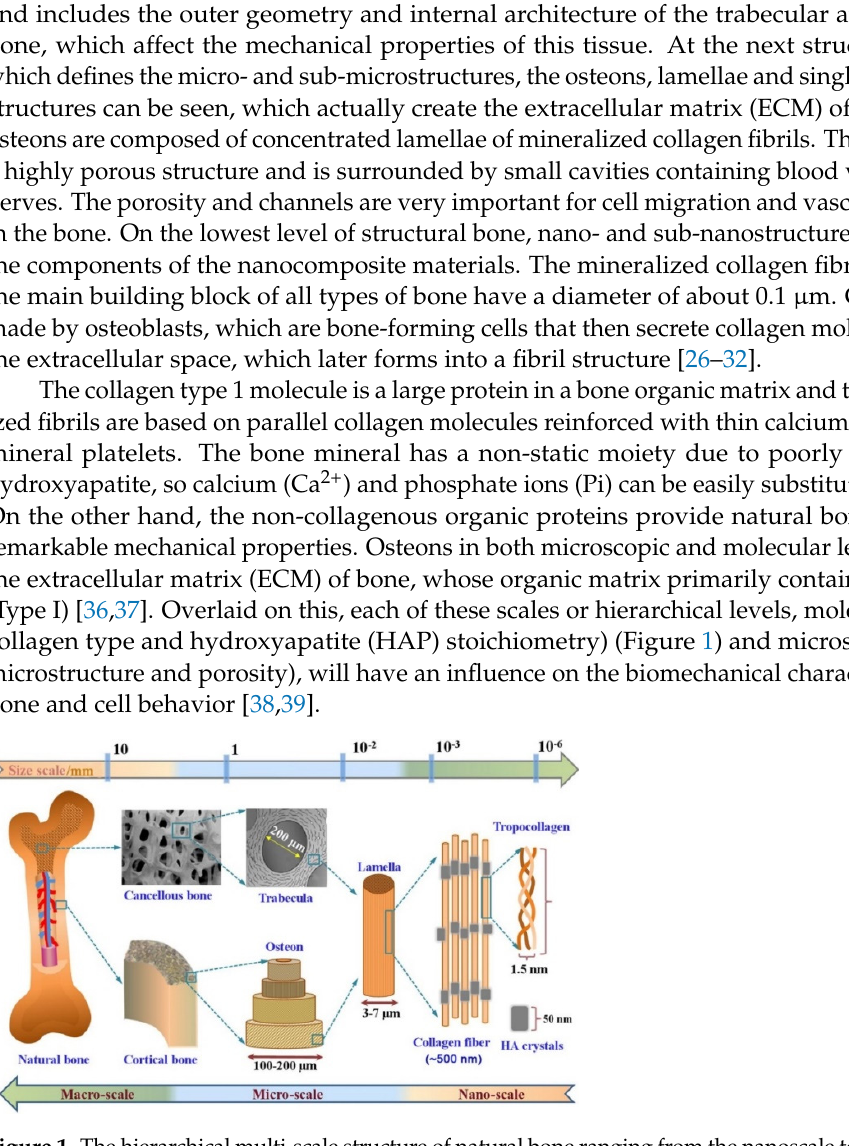
Figure 1. The hierarchical multi-scale structure of natural bone ranging from the nanoscale to mac- roscale. Reproduced with permission from Ref. [38] . Reproduced with permission from Ref.